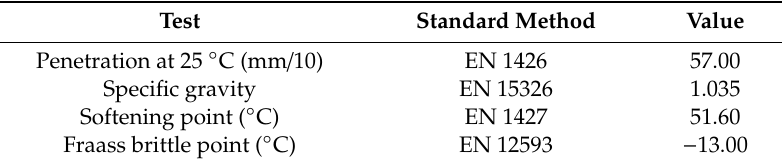
Table 3. Main binder properties.